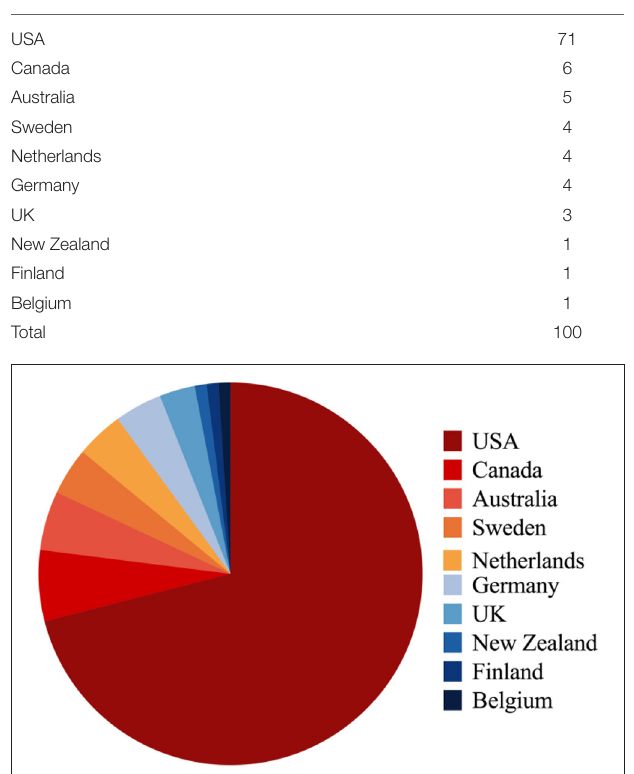
Figure 5 indicated the top 100 most-cited publications